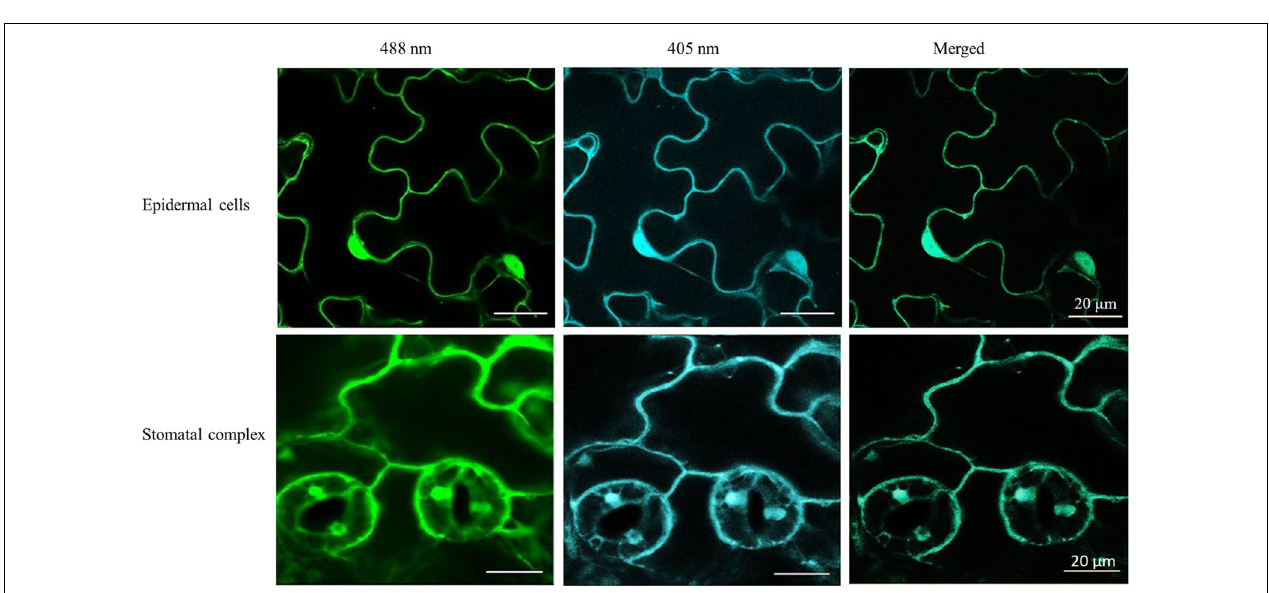
FIGURE 4 | Examples of typical ro-GFP2 fluorescence images of the epidermal cells and stomatal guard cells on leaves exposed to heat stress (42 ◦ C) for 1 h. Scale bar is 20 µ m.